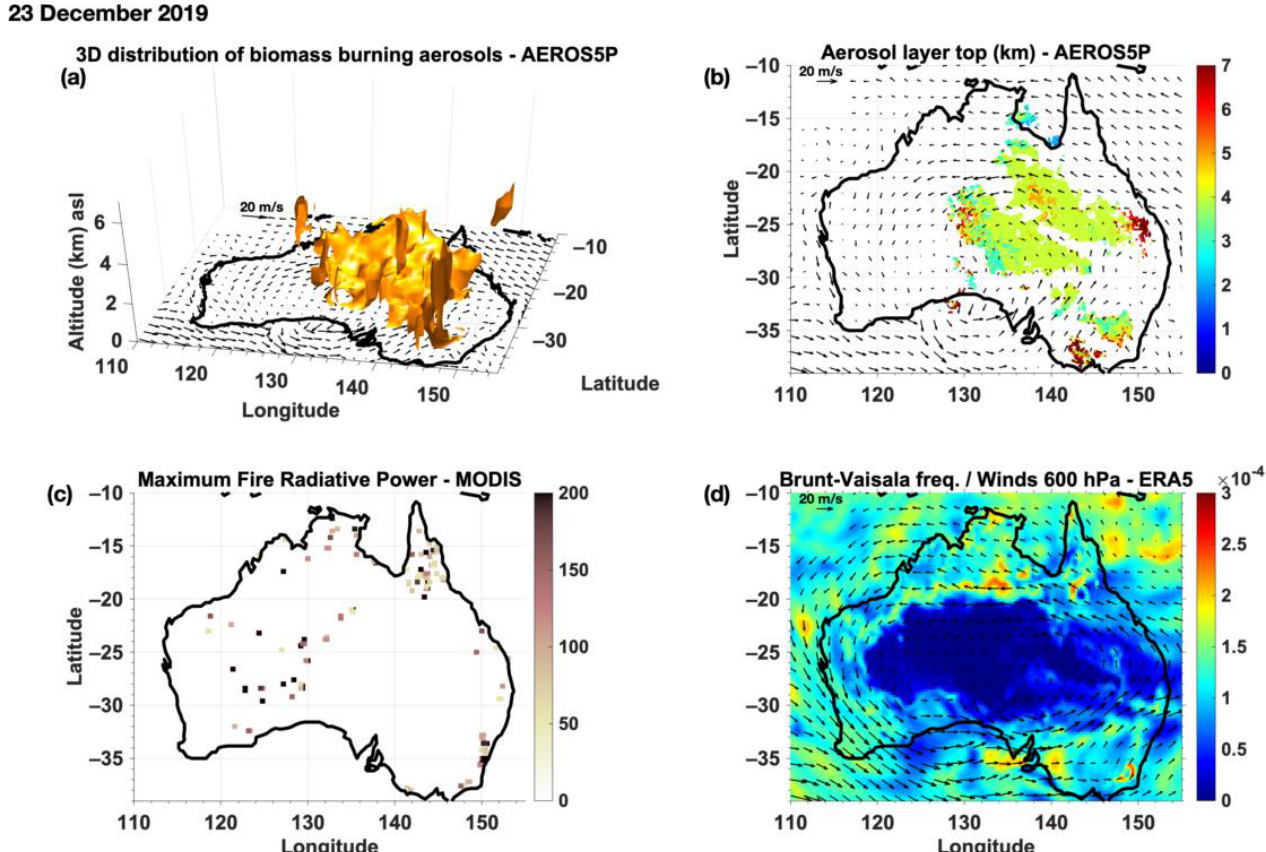
Figure 9. Same as Figure 6 but for 23 December 2019.